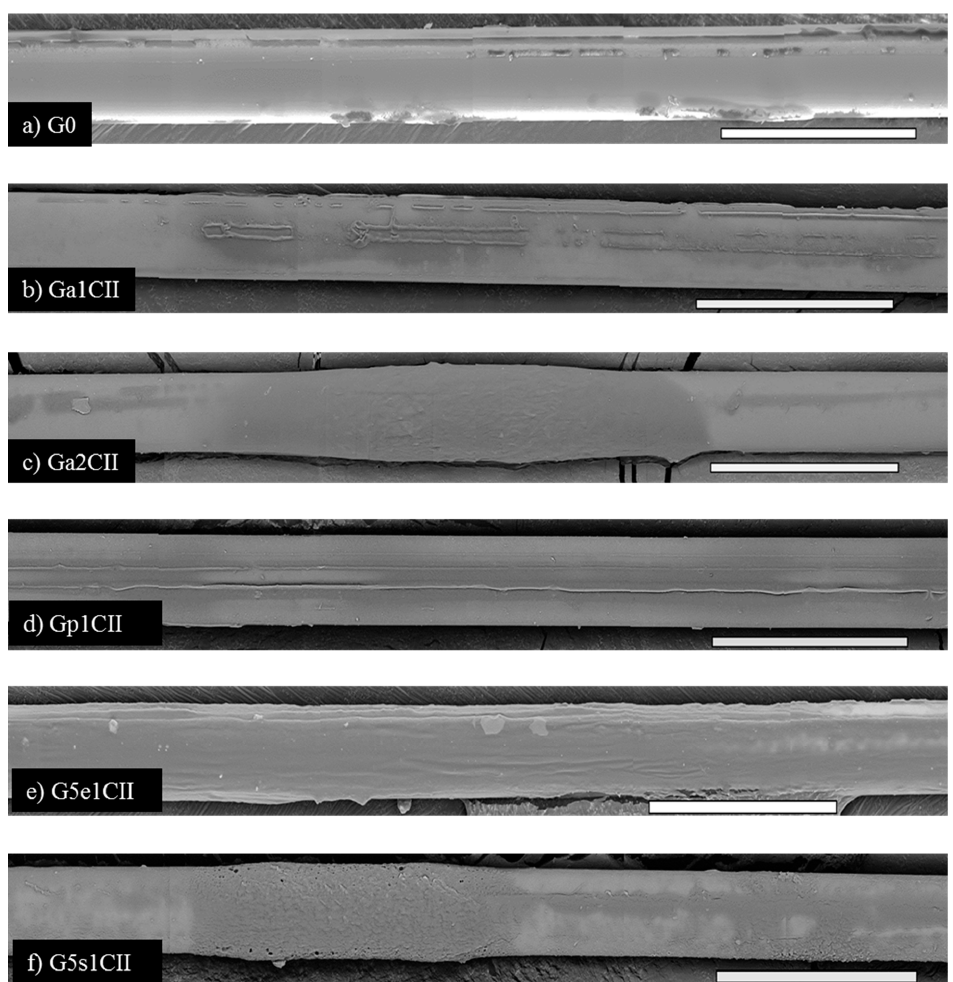
Figure 4. Coating morphology observed by SEM for different coating dispersions. ( a ) Control G0, and various coatings containing CNCPh: ( b ) Ga1CII, ( c ) Ga2CII, ( d ) Gp1CII, ( e ) G5e1CII, ( f ) G5s1CII. Scale bar = 50 µ m.